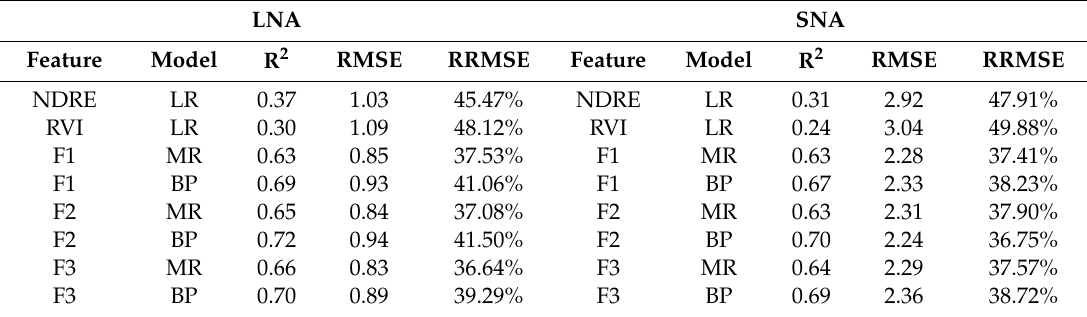
Table 3. Comparison of LNA and SNA estimates derived from di ff erent features in the early jointing stage, in which F1 represents the feature set extracted based on the fused image, F2 represents the set based on the fused image features and the RVI, and F3 represents the set based on the fused image features and the NDRE.